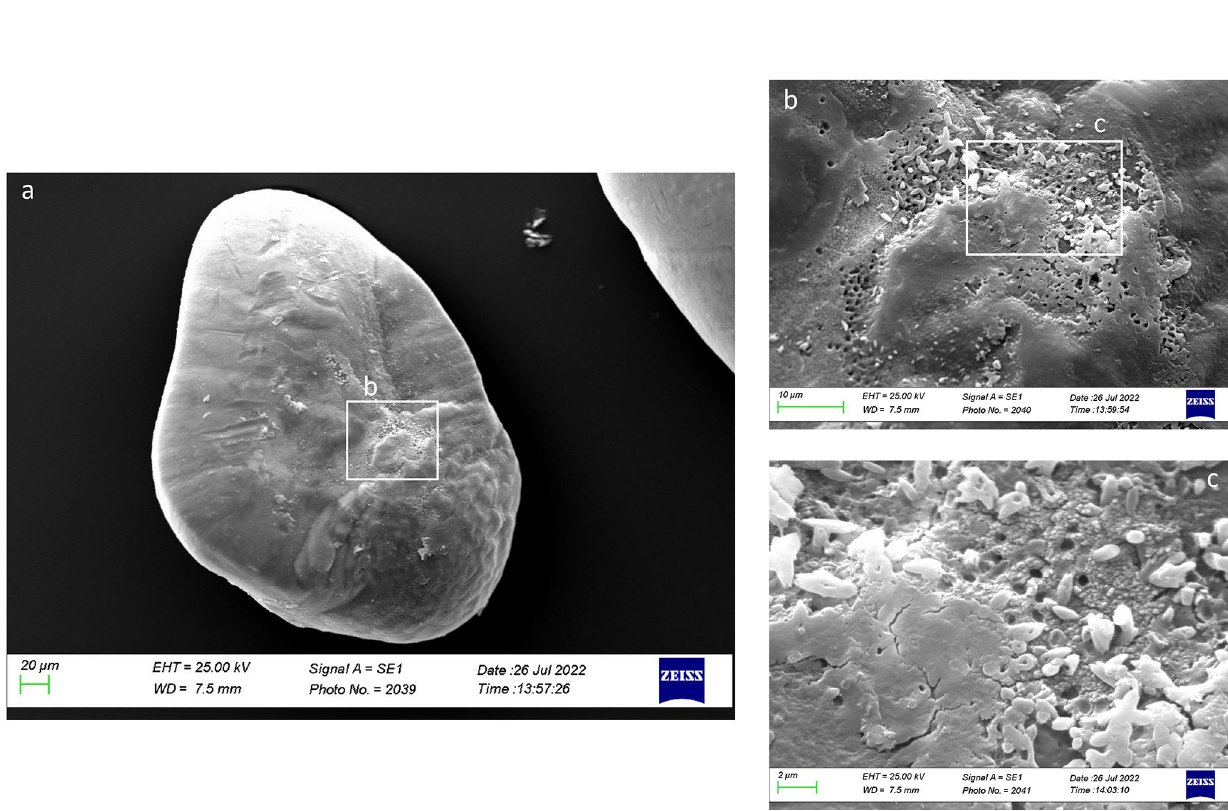
Fig 21. SEM images of a lapillus ventral surface belonging to size Class IV (a) with detail of the gibbus maculae and prominentia marginalis external textural organization and crystalline habits (b, c).